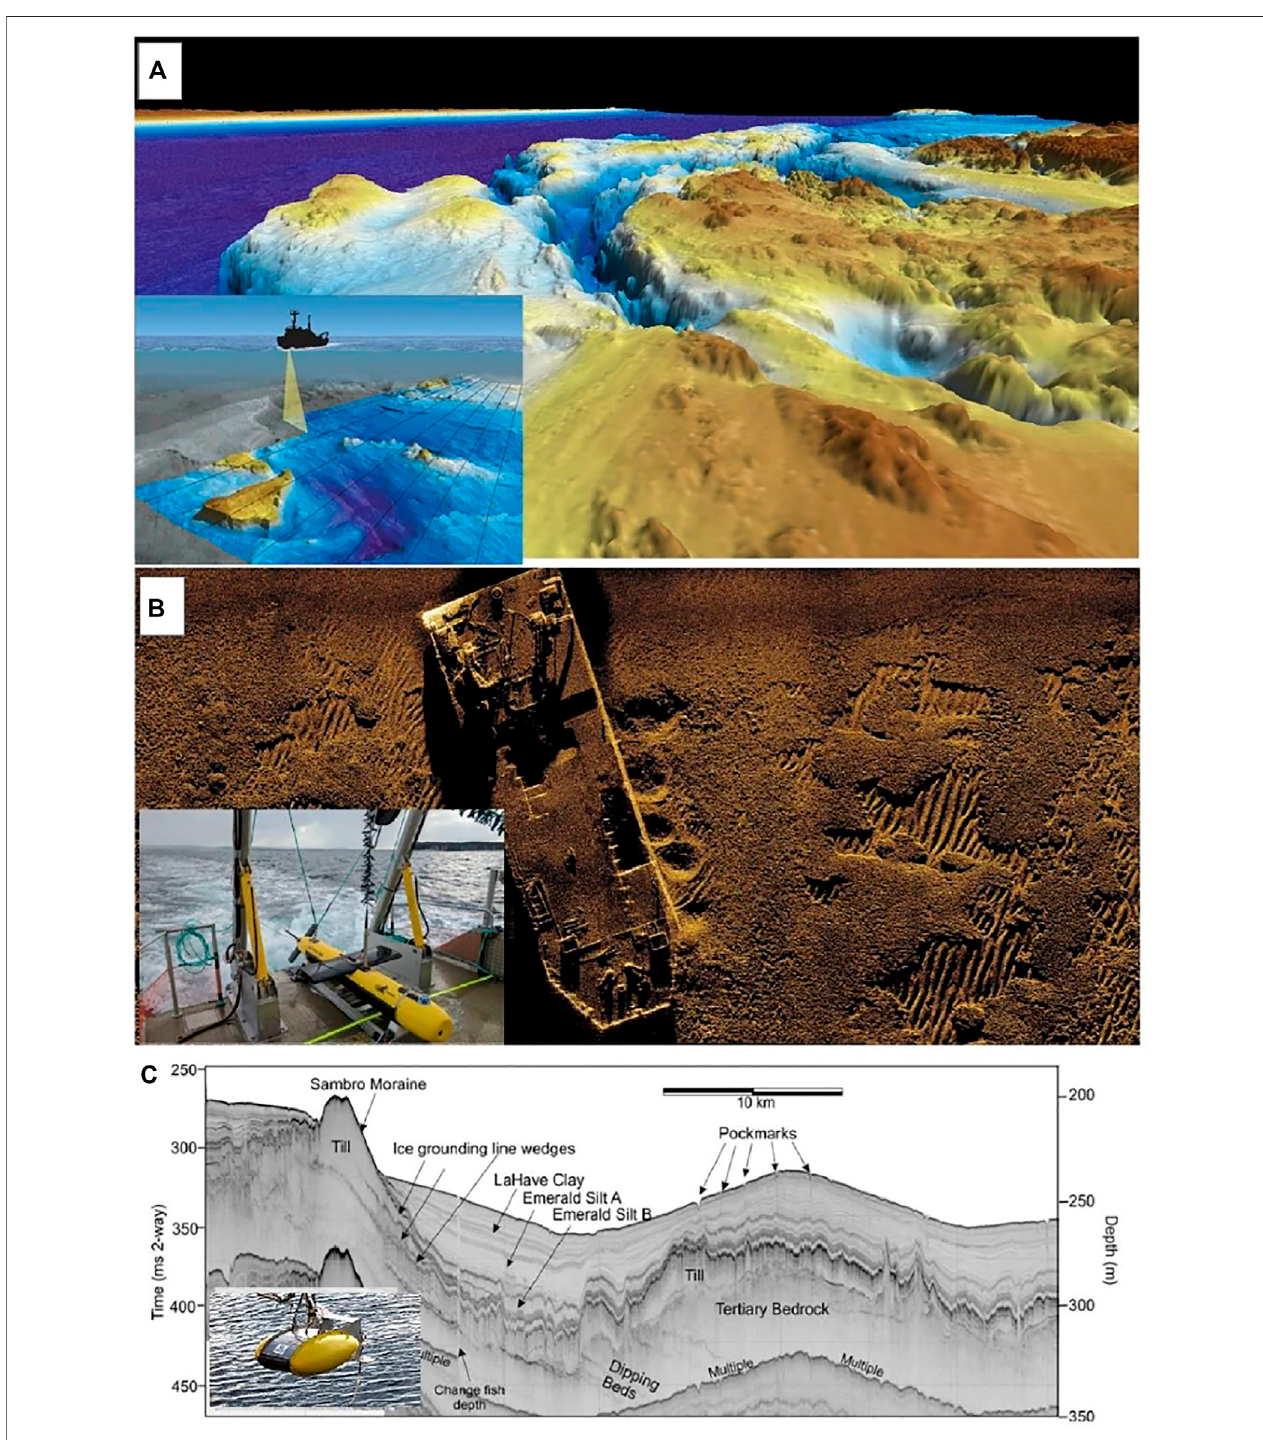
FIGURE 1 | Examples of active acoustic remote sensing data sets and sensors. (A) Multibeam echosounder bathymetry showing a 3D view of a digital elevation model of the sea fl oor derived from multibeam bathymetric measurements. Inset image shows how MBES data sets are collected. Imagery courtesy of the Dalhousie University, Seascape Ecology and Mapping Lab (www.sea fl oormapping.ca); (B) Synthetic Aperture Sonra data set showing a ship wreck and sea fl oor sediment bedforms. Datais 3 cmhorizontalresolution and collectedfrom a towedSAS system shown inset ( Kraken Robotics Kat fi sh ).Imagery courtesy ofKraken Robotics (https://krakenrobotics.com/); (C) Sub-bottom pro fi ler data showing sediment stratigraphy beneath the sea fl oor. The pro fi le was collected using a towed sensor platform ( Geoforce DTS ). Imagery courtesy of Geoforce Group Ltd. (https://www.geoforcegroup.com/).